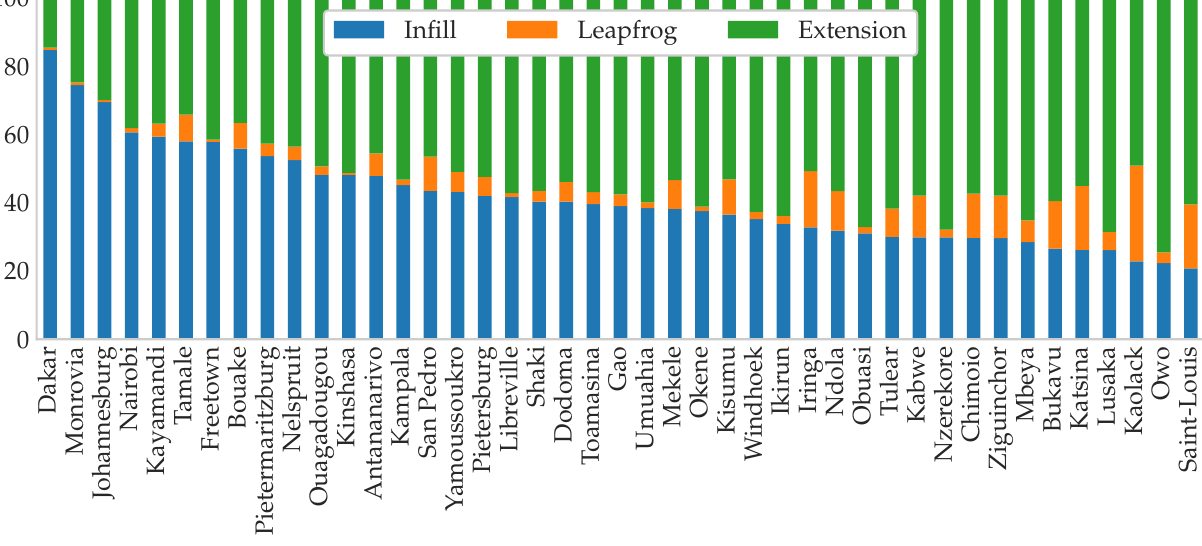
Figure 9. Share of each type of newly built-up area between 2000 and 2015 for each case